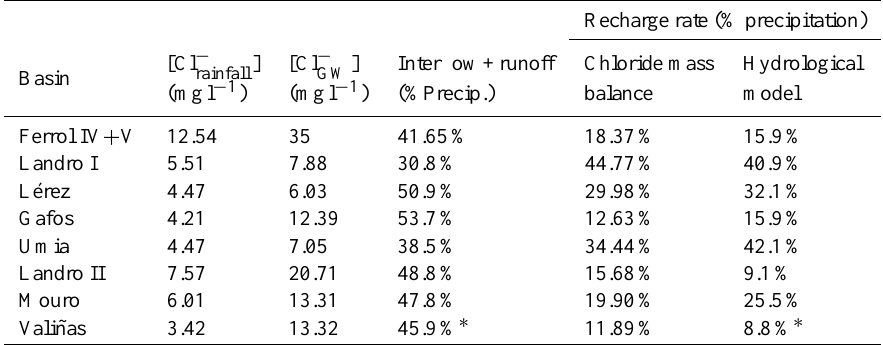
Table 3. Comparison of groundwater recharge computed by different methodologies.